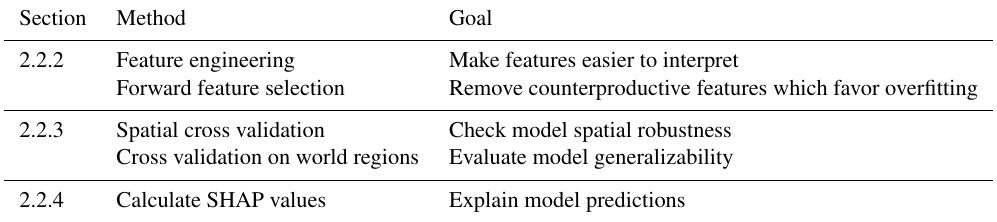
Table 2. Machine learning experiments as an addition to the standard mapping method. For details on the methods, refer to the given sections.